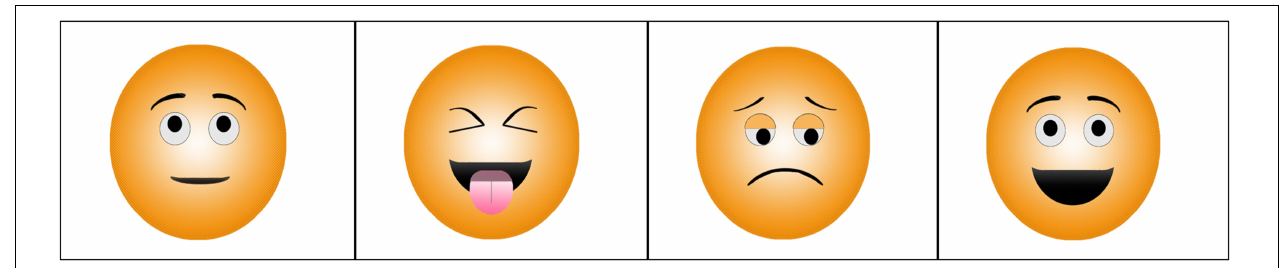
FIGURE 2 | Examples of AGENT emotions (from left to right: neutral, malicious joy, sad, happy; translated from German).